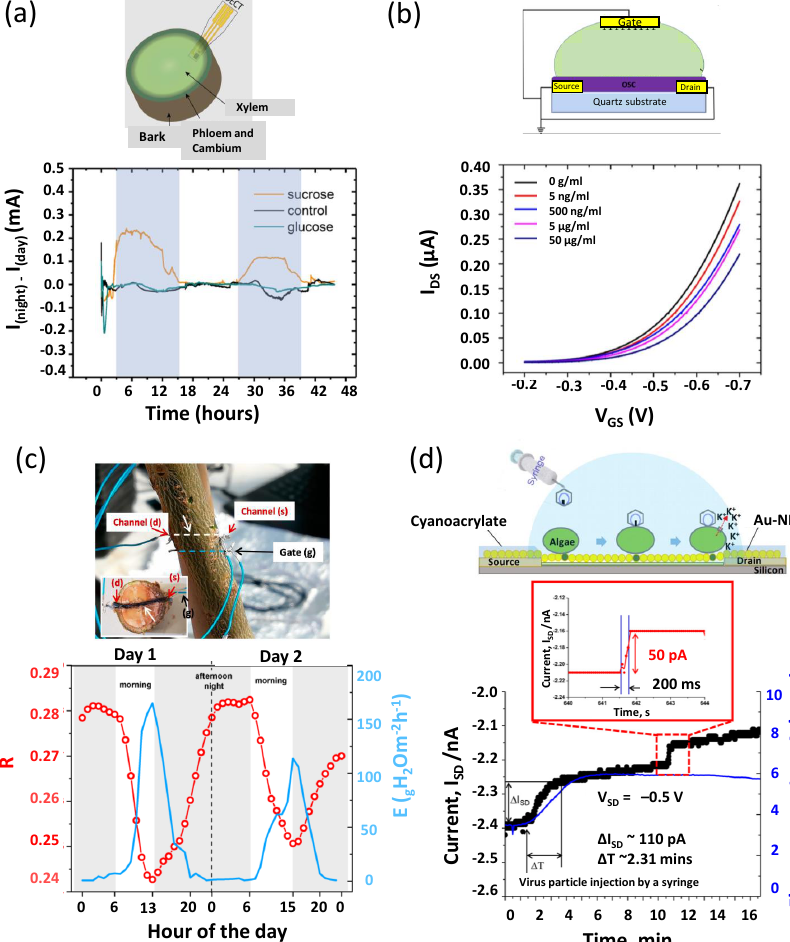
Figure 5. Examples of bio-FETs developed for plant monitoring. ( a ) OECT developed to monitor plant xylem metabolites. Top: device setup; the sensor was inserted into the xylem of the tree stem. Bottom: Instantaneous monitoring of sucrose (orange), glucose (cyan), and control (black) for 2 days. Bright areas correspond to daytime, while dark areas are related to nighttime. Re-adapted with permission from [122]. Copyright 2022, Elsevier. ( b ) EG-FET for the detection of plant viruses. Top: Cross-view of final device. Bottom: Transfer characteristics of the sensor after being exposed to various plum pox virus (PPV) concentrations (from 0 to 50 µ g/mL); a decrease in current is shown with increasing concentrations of PPV. Re-adapted with permission from [53]. Copyright 2022, Elsevier. ( c ) OECT for the detection of ions in olive trees. Top: a representation of the sensor setup inserted into the stem of an olive tree. Bottom: diurnal fluctuations of the sensor response R (o) and plant transpiration (E) (cyan line) sensed for 48 h. Re-adapted with permission from [107]. ( d ) Bottom-gate FET for monitoring microalgae membrane depolarization. Top: representation of the sensor functionalized with algae cells and infected with viruses introduced with syringe. Bottom: the current changes upon virus infection. Reprinted with permission from [120]. Copyright 2022 American Chemical